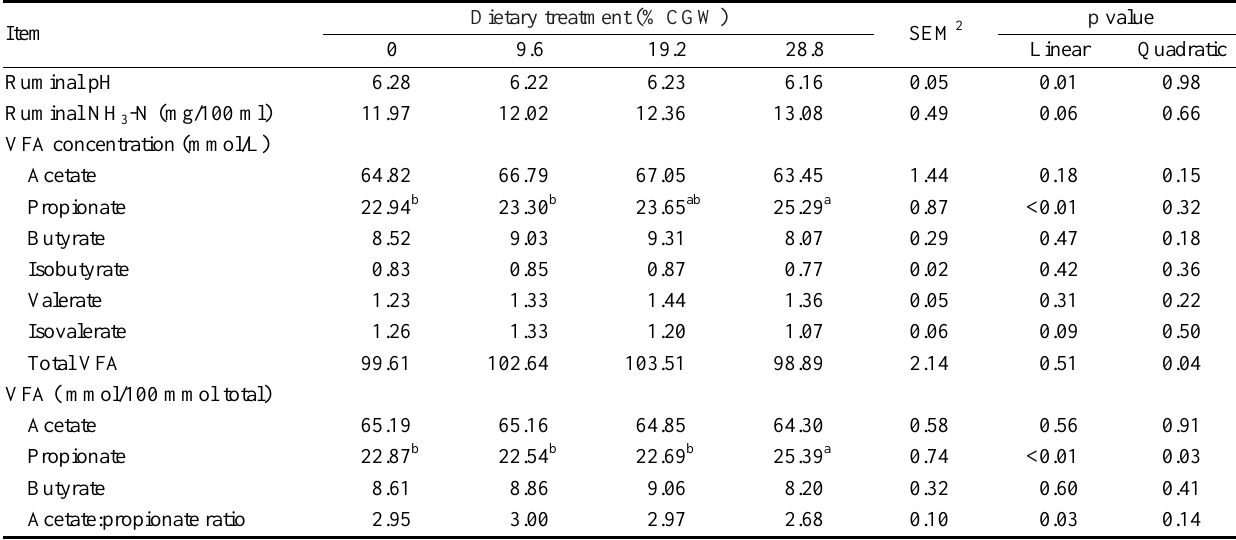
a-b Means with different superscripts in the same row differ (Tukey’s test; p<0.05). 1 Values are means across sampling times of 0, 3, 6, 9, and 12 h after morning feeding. 2 SEM = Standard error of the mean.